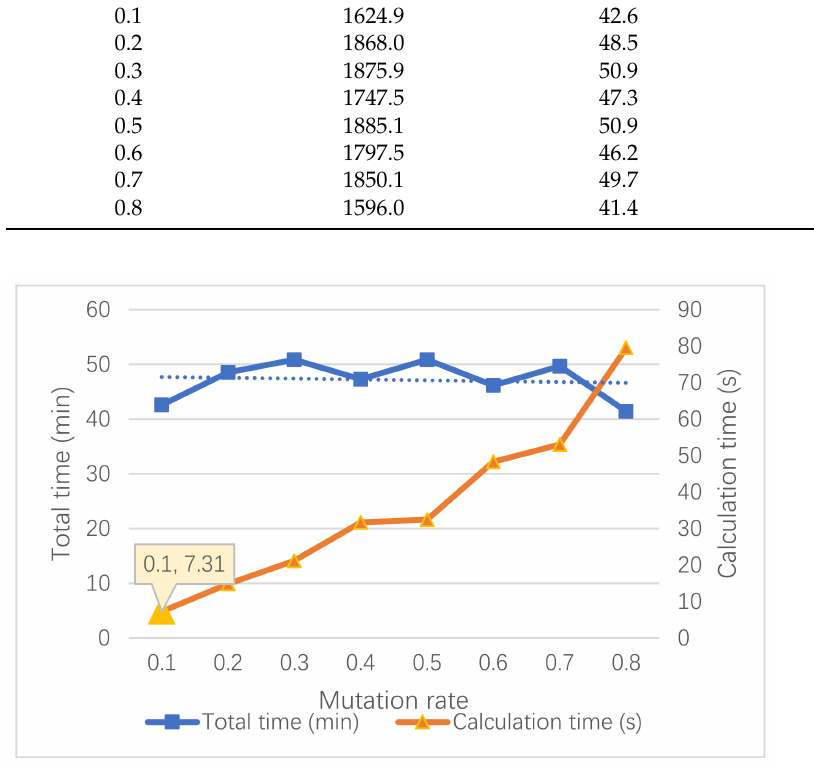
Figure 13. Influence of mutation rate on